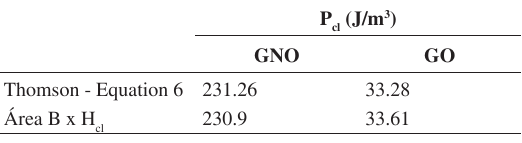
Table 4. Comparison between the internal area of the B x H described in Figure 1 and classical eddy current loss estimated from Equation